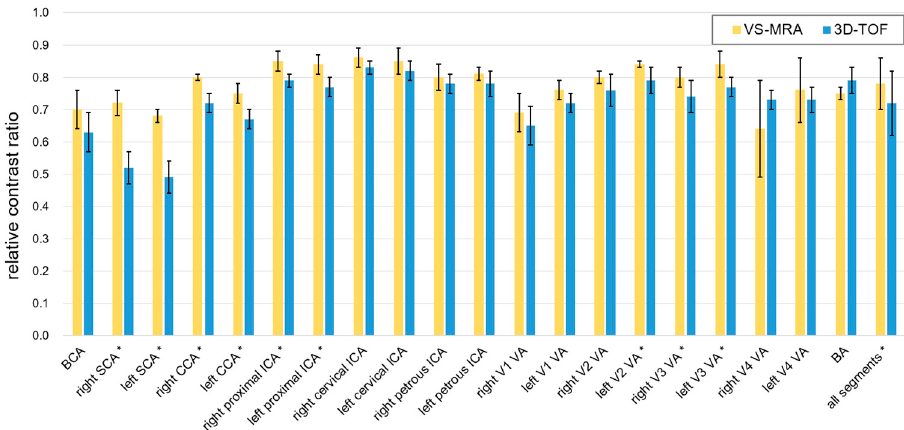
Figure 4. Coronal ( A , C ) and sagittal ( B , D ) partial MIP images of 3D time-of-flight (TOF) ( A , B ) and VS-MRA ( C , D ) in a healthy subject, and axial slices in the middle of each station for VS-MRA ( G , H ) and in the same locations for 3D-TOF ( E , F ). Both 3D TOF and VS-MRA visualize most of the major arteries well over the whole neck. VS-MRA images show improved visualization of small vessels, such as facial and occipital arteries (white arrows), and horizontally oriented arteries, such as subclavian arteries (blue arrows), and also improved the suppression of background signals compared to 3D TOF.